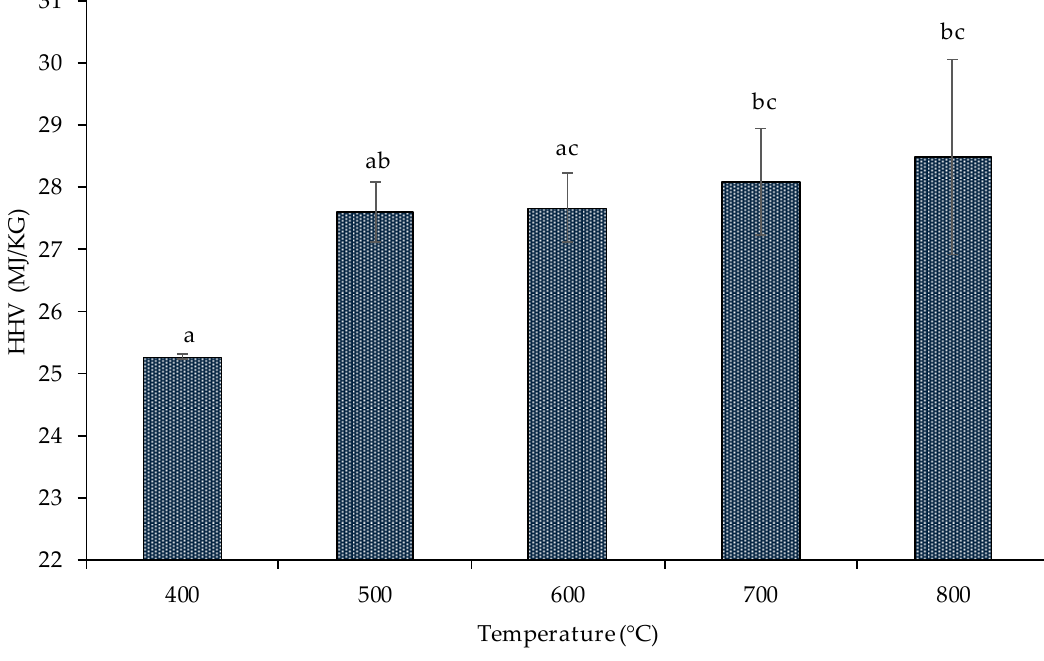
Figure 5. Effect of temperature on HHV in coconut shell bio-char, where each bar indicates the mean ± standard error [ SE ( n = 3)]. Note: distinct letters in each specific yield bar indicate significant differences ( p ≤ 0.05).